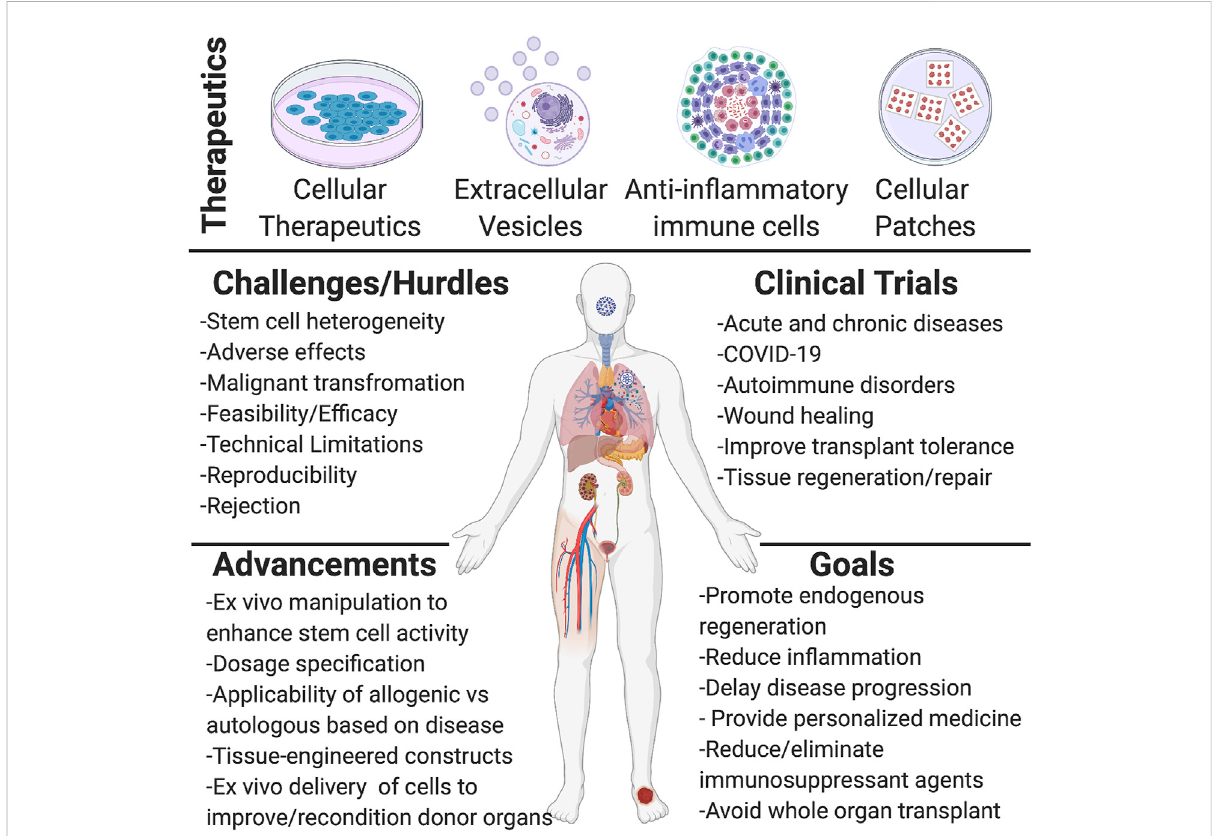
FIGURE 1 Schematic representation of regenerative medicine therapeutics and current knowledge acquired. The fi rst half of the scheme shows the differentformsoftherapeuticsusedandinvestigatedforregenerativemedicineapplications,suchasdifferentcellularmaterials(mesenchymalstem/ stromal cells(MSCs),inducedpluripotent stemcells(iPSCs),progenitor cells),extracellularvesicles(exosomes,microvesicles, andapoptoticbodies), anti-in fl ammatory immune cells (M2 macrophages, Treg cells, Chimeric antigen receptor transduced natural killer (CAR-NK)), and cellular patches(tissue-engineeredoralmucosagraft,bilayerlivingcellconstruct,cardiacpatch).Thesecondhalfoftheschemeshowsthemanychallenges and hurdles currentlypresentwith cellular therapies, such as ef fi cacy and safety and the various improvements made inregenerative medicine. A list of different targets of clinical trials is listed, along with the different overall goals from such targets. Created with